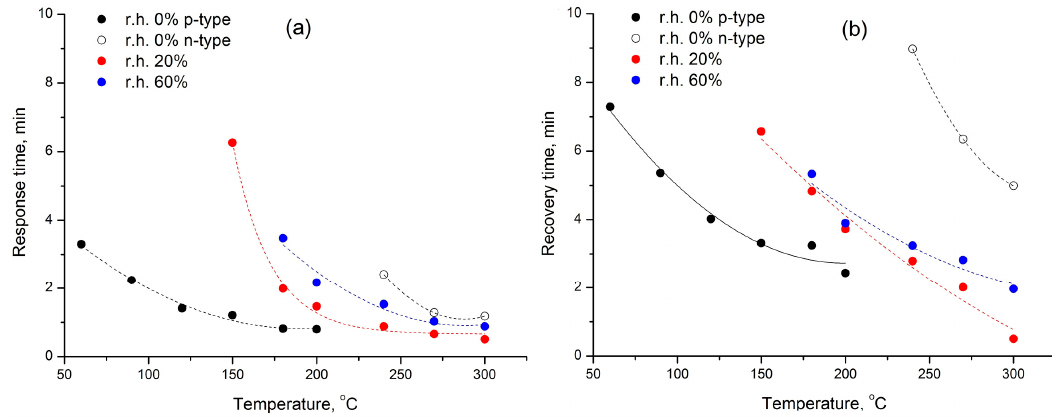
Figure 12. Values of response ( a ) and recovery ( b ) time as a function of temperature at 0, 20 and 60% r.h.